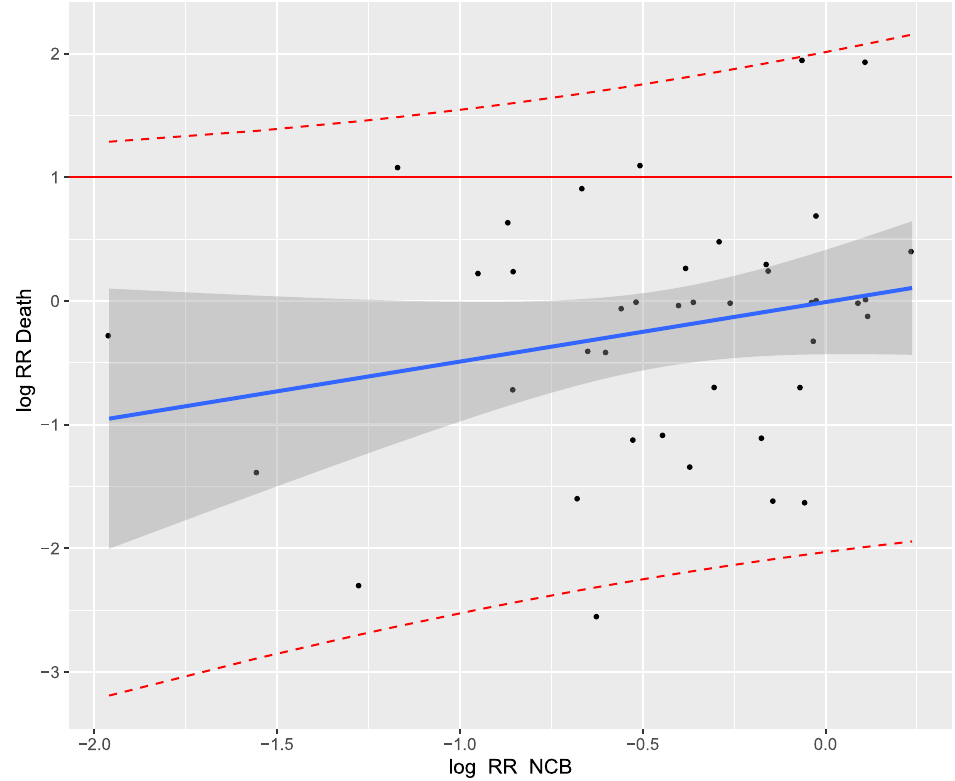
Figure 6. Trial-level association between treatment effects on net clinical benefit (NCB) and all-cause mortality in the treatment of the major orthopedic and abdominal surgery. Cor = 0.24 with the linear regression model "Log RR Death = 0.49 × Log RR NCB − 0.05". Each study is represented by a circle. A log scale was used for the x-axis and y-axis. The solid blue line represents the regression line and the grey area represents the 95% confidence interval. The red dashed lines represent the upper and lower limits of the 95% prediction interval. RR, relative